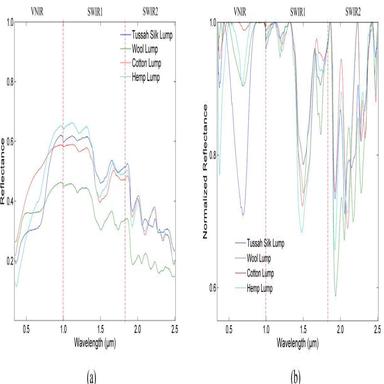
Spectral comparison between textile samples of different fiber types, (a: reflectance spectra; b: CR spectra).